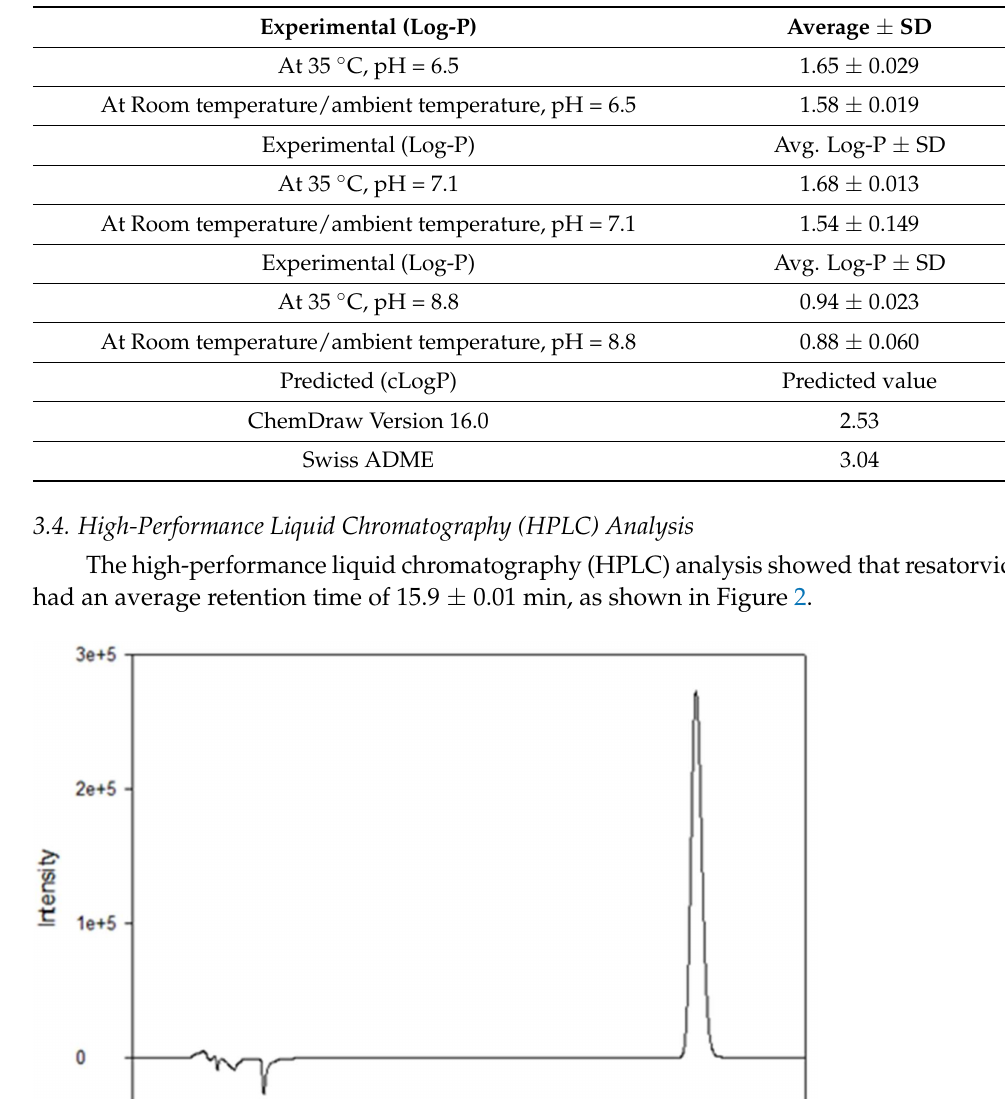
Table 1. Summary of partition coefficient (Log-P) for resatorvid at various pH (n = 3, mean ± standard deviation).